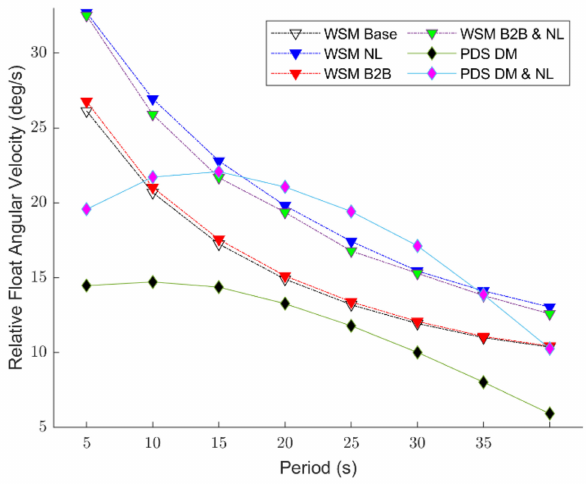
Figure 5. WEBS relative float angular velocity oscillation magnitude in regular waves. B2B interactions do not have a significant impact on WEBS dynamics. When compar- ing WSM Base to WSM B2B or WSM NL to WSM B2B and NL, the relative float